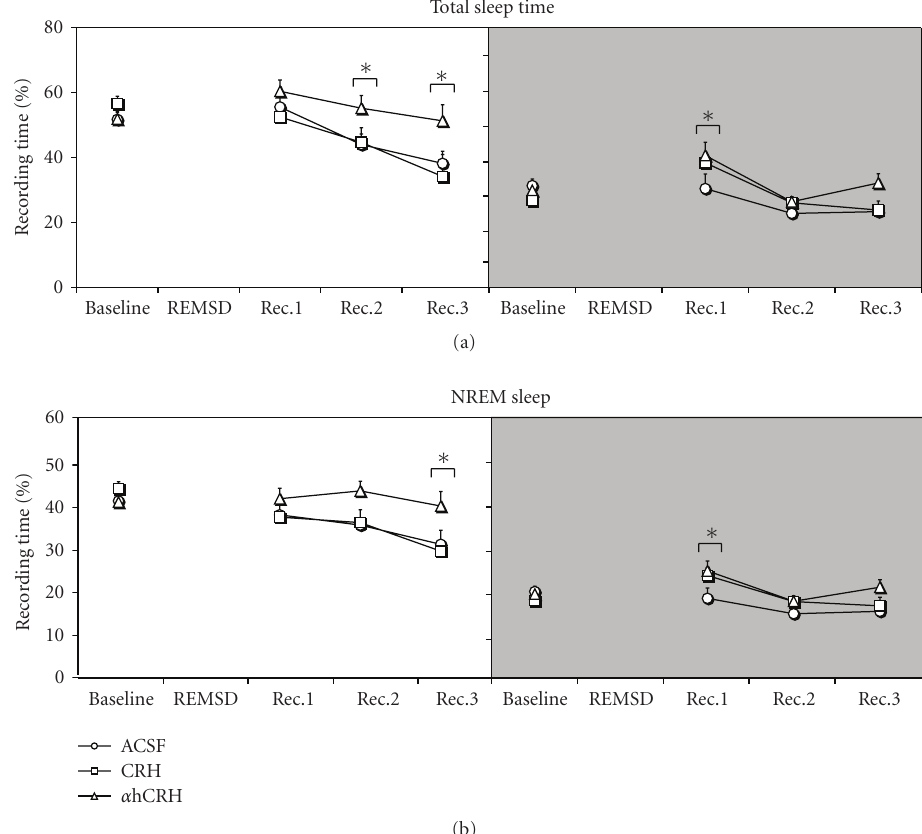
Figure 2: NREM Sleep . Data were obtained in recording periods of approximately 11 hours during the light and dark phases. ACSF, artificial cerebrospinal fluid; CRH, corticotrophin-releasing hormone; α hCRH, alpha helical CRH 9 − 41 ; REMSD, 96 hours REM sleep deprivation period; Rec. Recovery period. The white back panels indicate the light phase and the shaded ones, the dark phase. ∗ - di ff erent from baseline, e ff ects of day are indicated by connecting lines above the symbols. ANOVA, followed by Newman-Keuls, P ≤ .